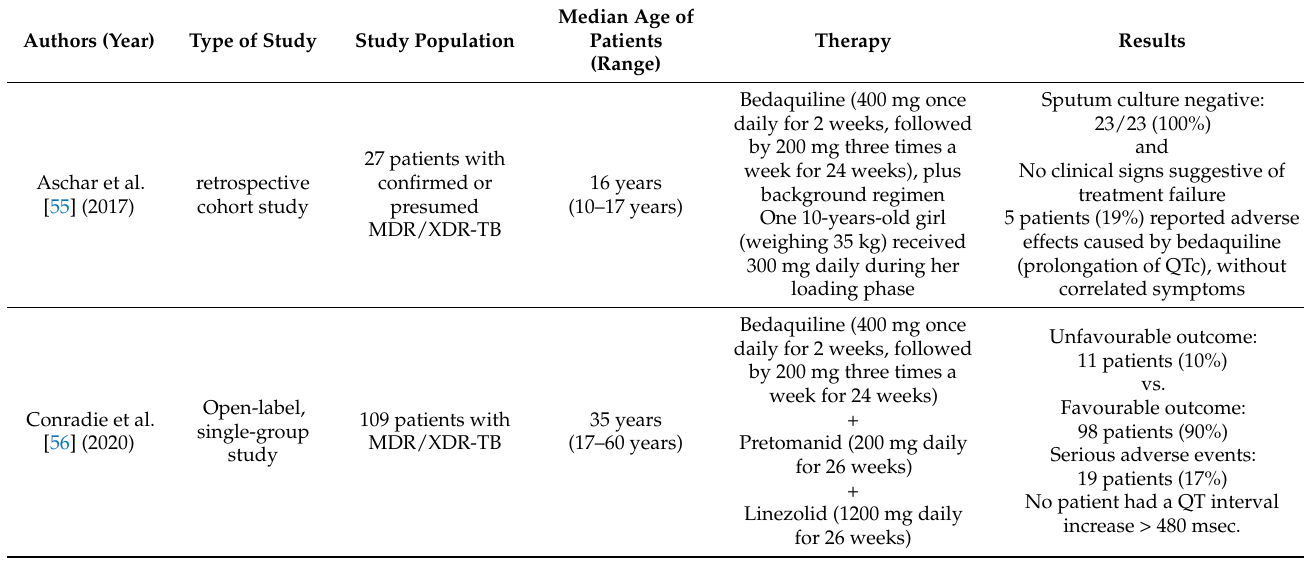
Table 3. Principal studies on bedaquiline in children and adolescents (0–18 years old) with MDR-TB.